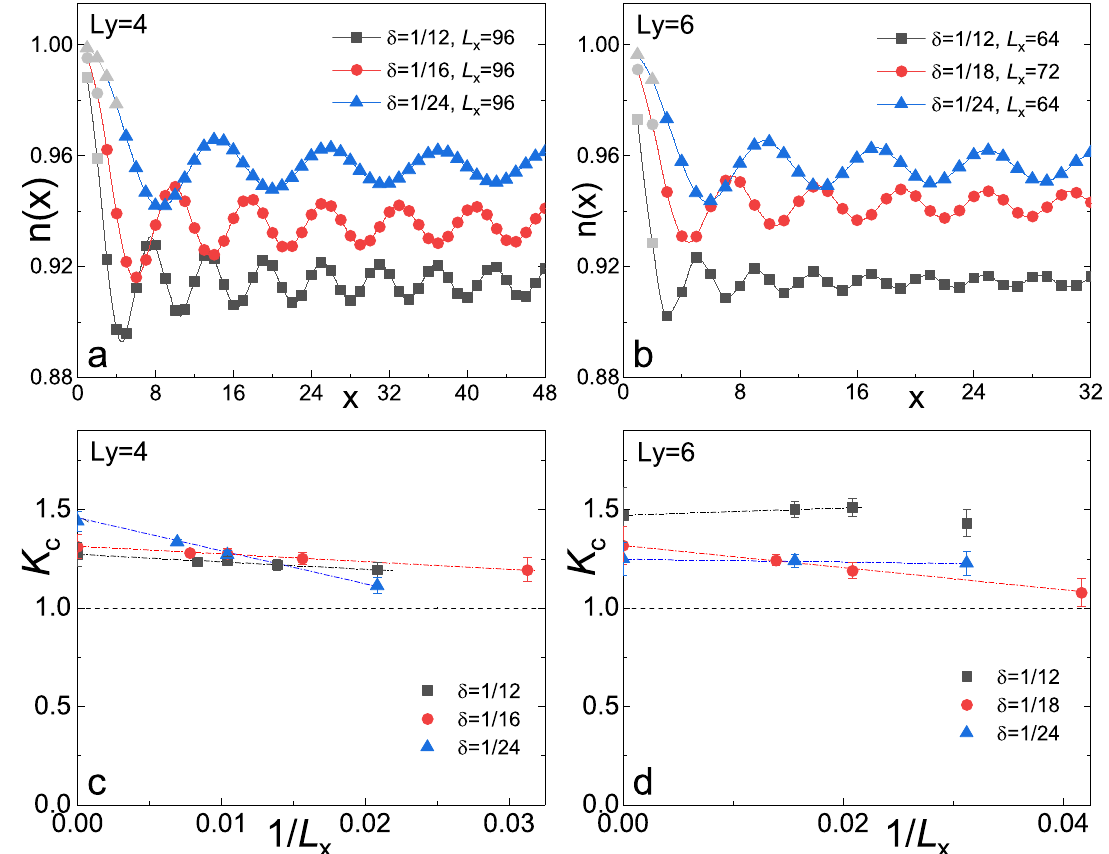
Fig. 2 Charge-density pro fi les and Luttinger exponent K c . Charge-density pro fi les n ( x ) for ( a ) L y = 4 and ( b ) L y = 6 cylinders of length L x at various doping levels δ . The extracted K c using Eq. (1) for ( c ) L y = 4 and ( d ) L y = 6 cylinders as a function of 1/ L x and δ , as well as their extrapolated value in the long cylinder limit 1/ L x = 0, i.e., L x → ∞ . A few data points in light gray are removed to minimize the boundary effect. Error bars denote the numerical uncertainty and the dash-dotted lines denote the linear